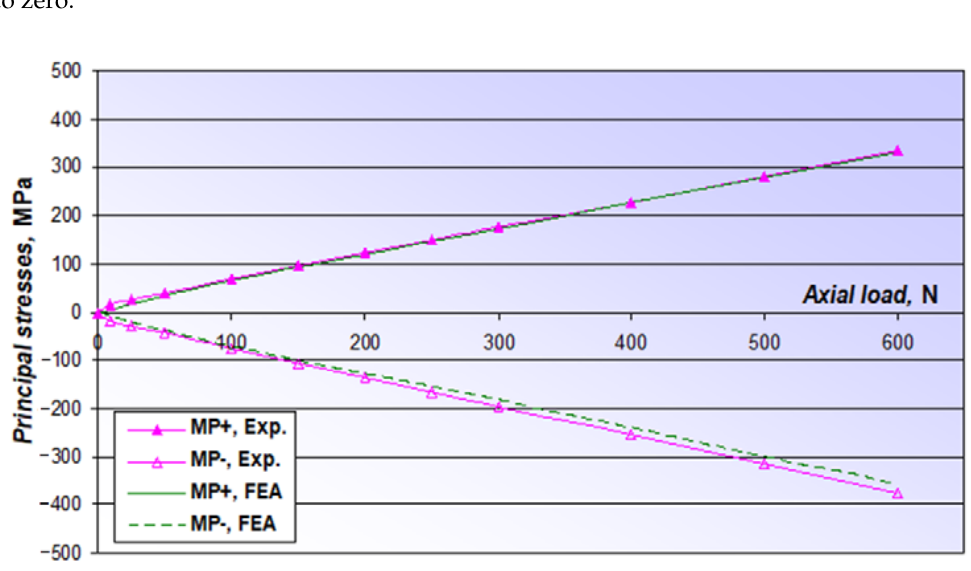
− ). σ 1 on MP+) and ( 3 on MP